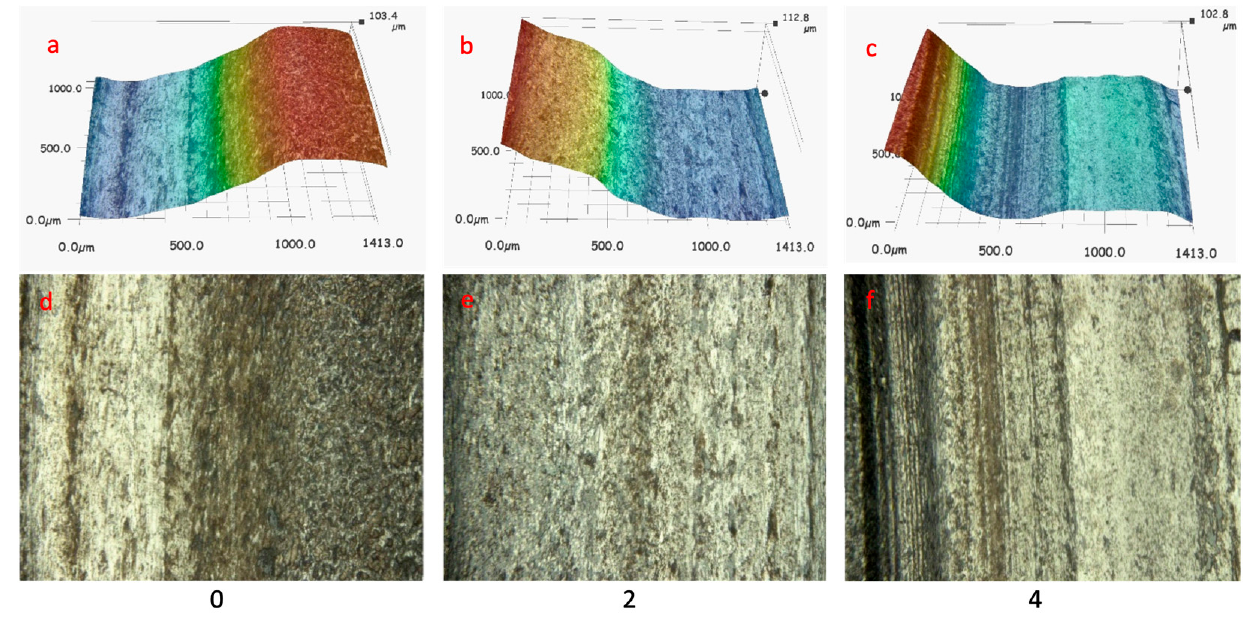
Figure 12. Depth profile and microstructure of the friction surface of the discs: ( a , d ) 0; ( b , e ) 2; ( c , f ) 4.